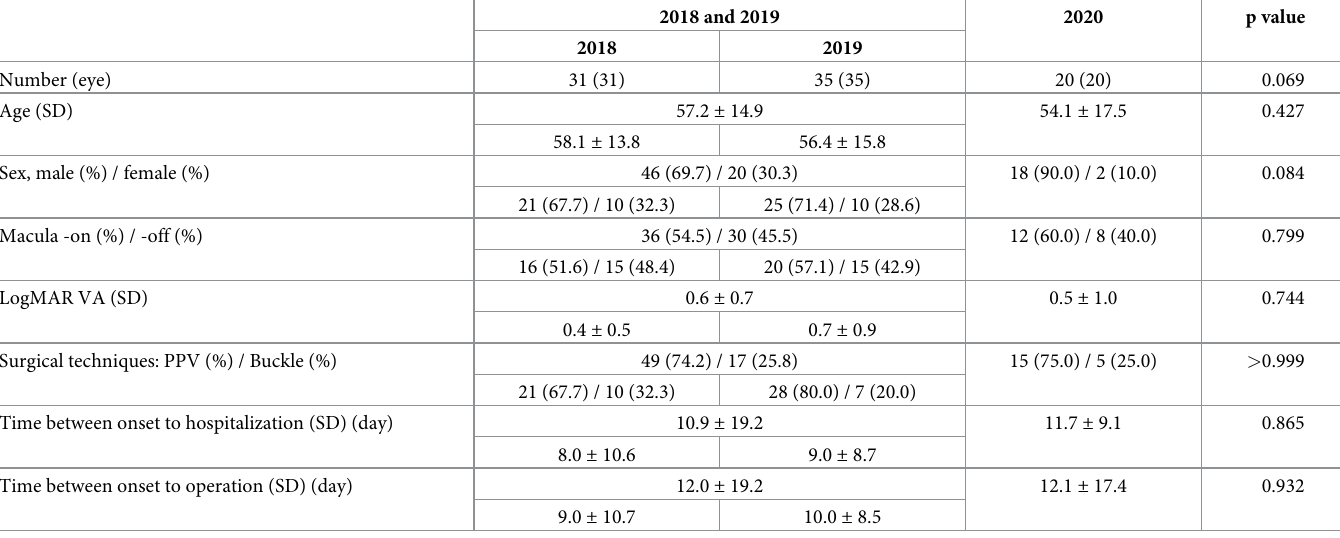
Table 1. Patient demographics and retinal detachment